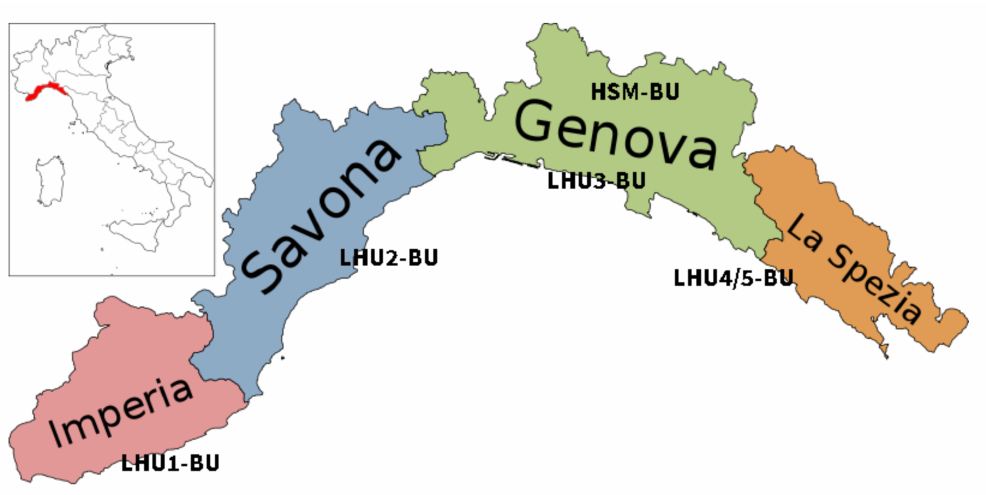
Figure 1. Map of the geographical area of the study site with the localization of the five Ligurian Breast Units. LHU1-BU: Breast Unit of Local Health Unit 1; LHU2-BU: Breast Unit of Local Health Unit 2; LHU3-BU: Breast Unit of Local Health Unit 3; HSM-BU: Breast Unit of IRCCS San Martino Policlinic Hospital; LHU4/5-BU: Breast Unit of Local Health Unit 4 and